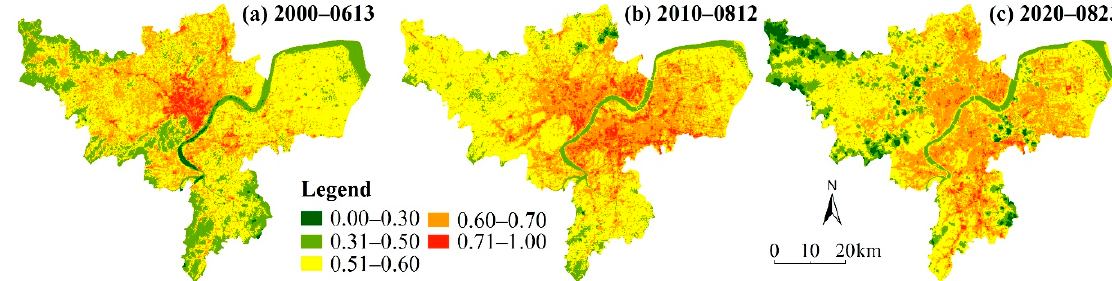
Figure 5. The proportions of contributions to the growth of impervious surfaces in Hangzhou City during different periods.